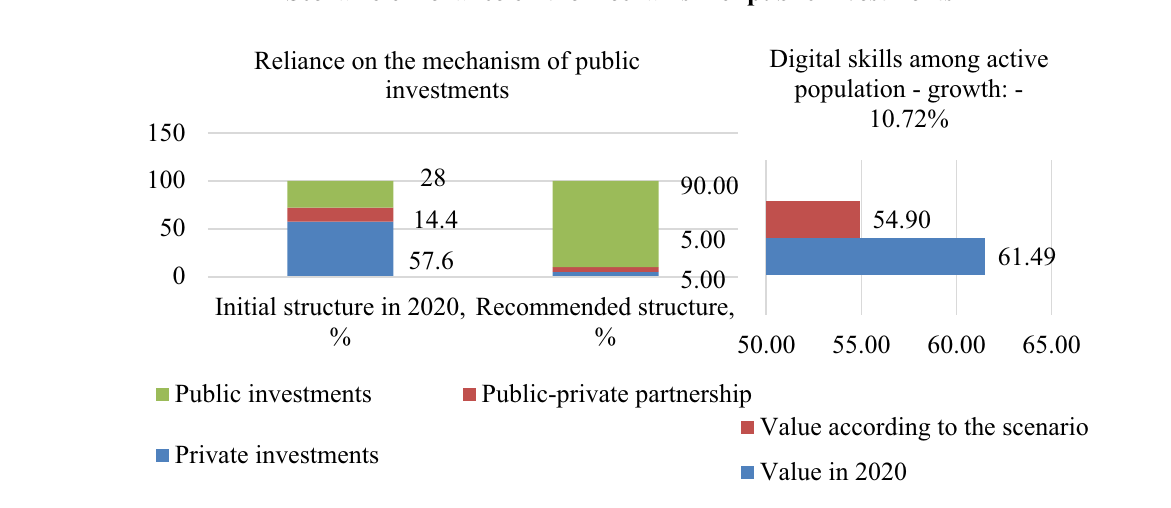
FIGURE 1 Education management in the social and investment model of economic growth according to the scenario of reliance on the mechanism of private investments and according to the scenario of reliance on the mechanism of public